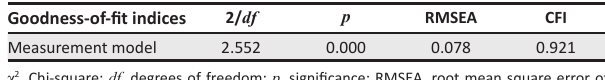
TABLE 3: Descriptive statistics per construct. Construct